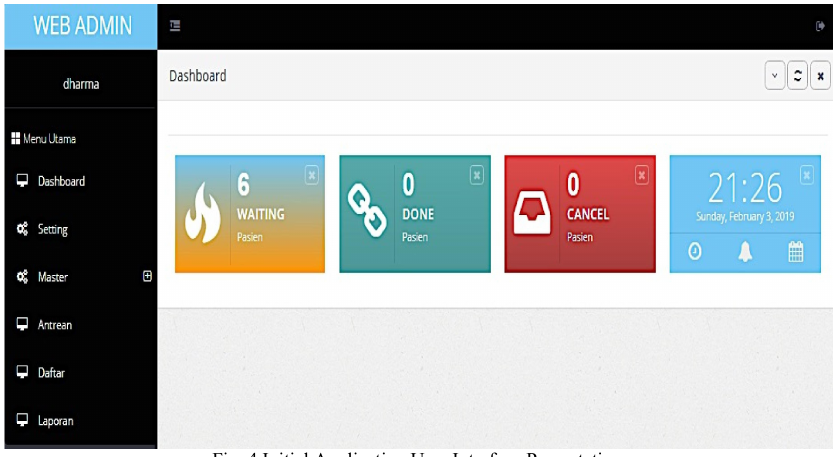
Fig. 4 Initial Application User Interface